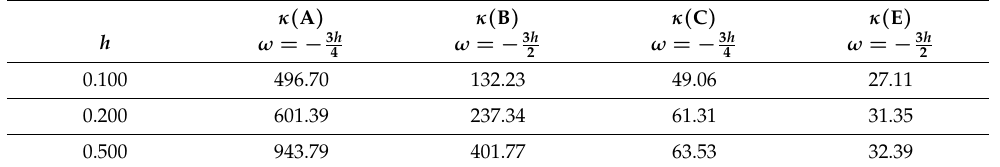
3 h and the discrete schemes (7)–(10) corresponding to 4 −